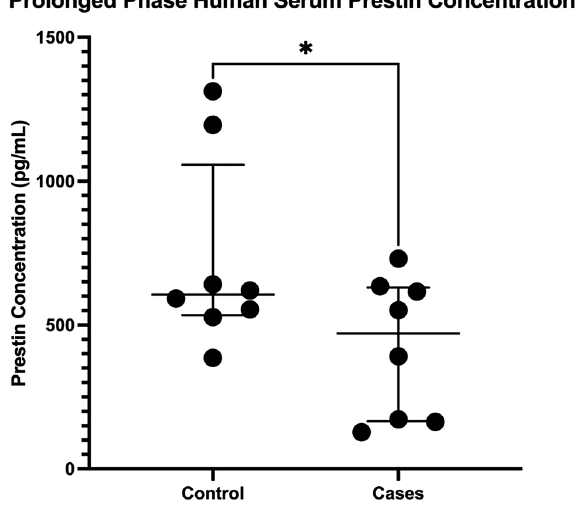
Figure 6. Prestin serum concentration in patients with signs and symptoms of hearing damage after receiving cisplatin compared to matched controls, median of differences = 328.5 pg/mL, p =